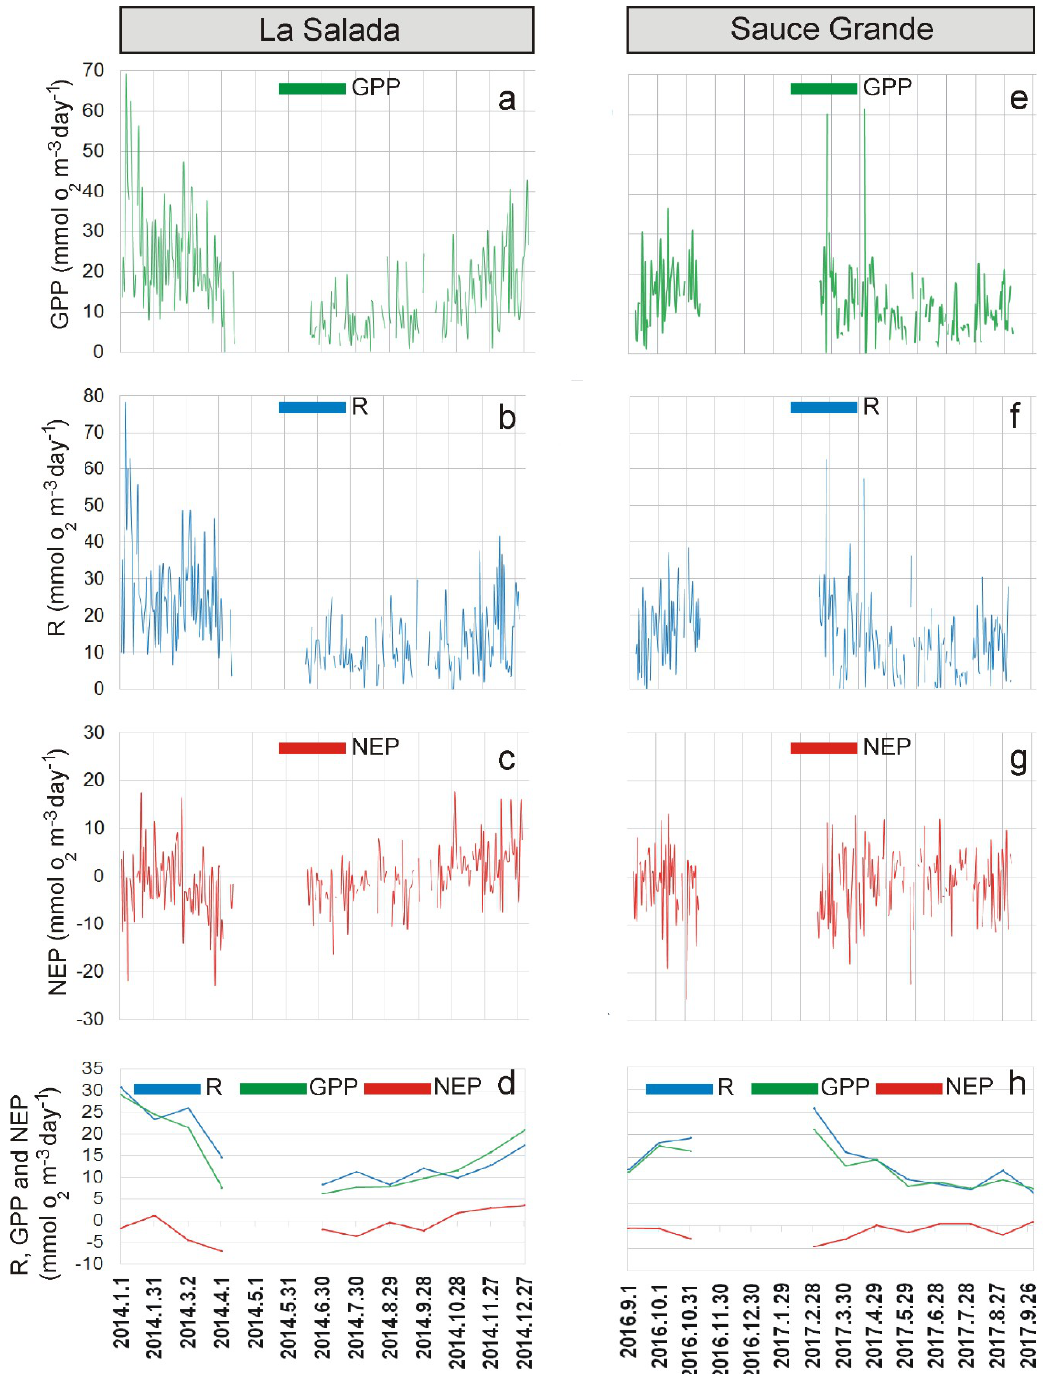
Figure 4. Calculated daily and monthly GPP: Gross primary production, R: community respiration, and NEP: net ecosystem production values for the ( a–d ) La Salada and ( e–h ) Sauce Grande lakes. and NEP: net ecosystem production values for the ( a – d ) La Salada and ( e – h ) Sauce Grande lakes. Gaps correspond to periods of replacement or cleaning and calibration of the sensors. Gaps correspond to periods of replacement or cleaning and calibration of the